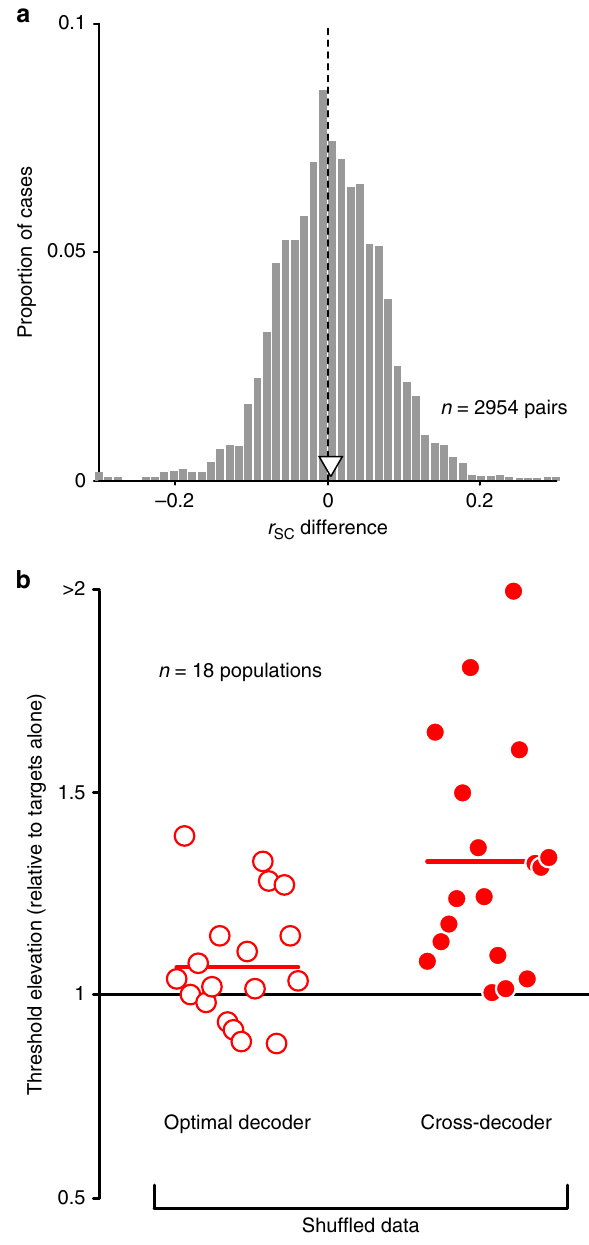
Fig. 6 Changes in correlations do not drive population information loss. a Changes in spike count correlation ( r SC ) with the presentation of distractors ( r SC with distractors — r SC for targets alone). Open arrowhead indicates mean. b The discrimination thresholds for each population, normalized by the thresholds for targets alone. Thresholds were measured using responses that were trial shuf fl ed to reduce correlations. Left: thresholds for targets with distractors, determined using an optimal decoder for each display, in open red circles. Right: thresholds estimated using a decoder optimized for shuf fl ed responses to targets alone and applied to shuf fl ed responses to targets with distractors. Source data are provided as a source data fi